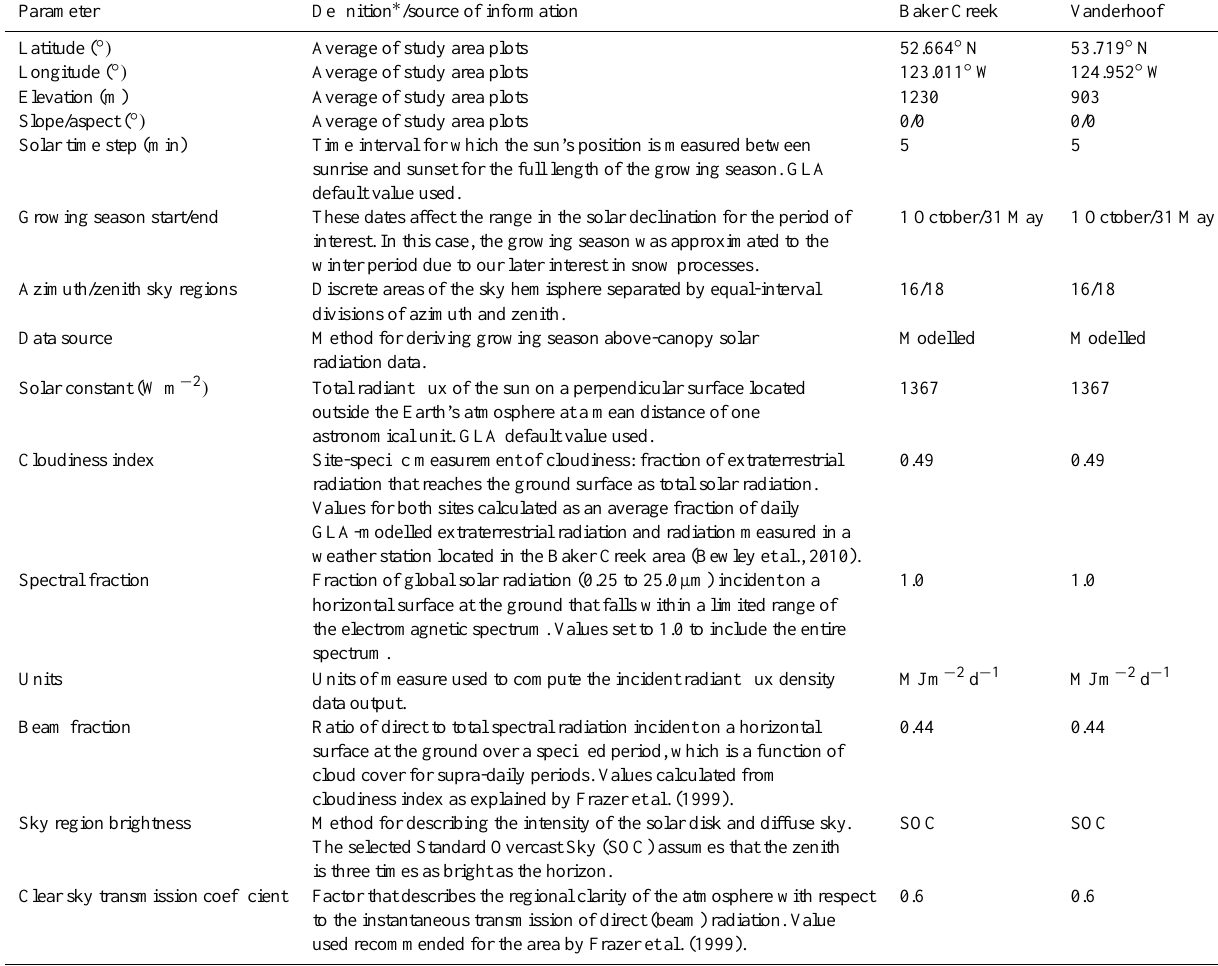
Table 3. Hemispherical photo parameter calibration.